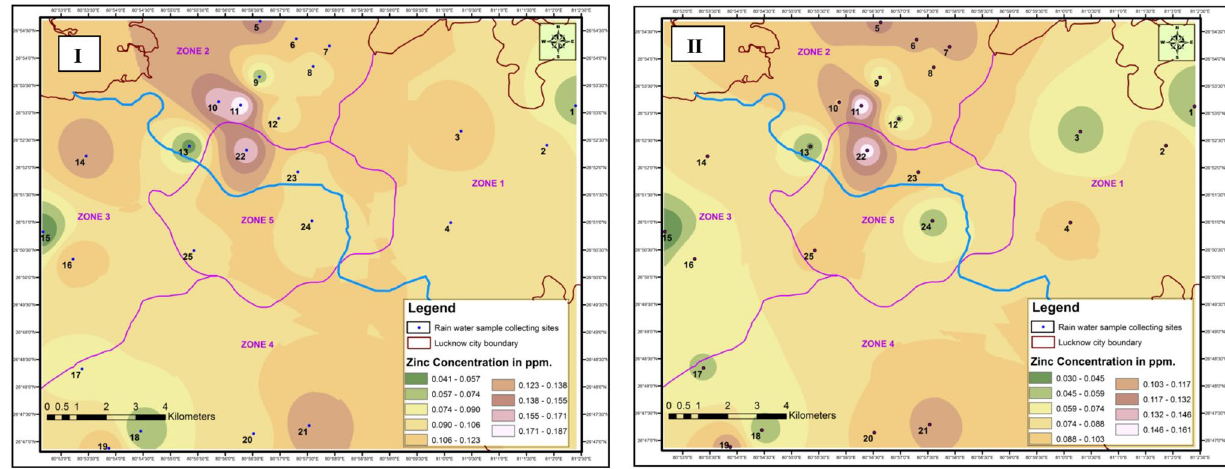
Fig. 4 Contour map of zinc values at five zones of Lucknow city during first (I) rainfall and second(II)